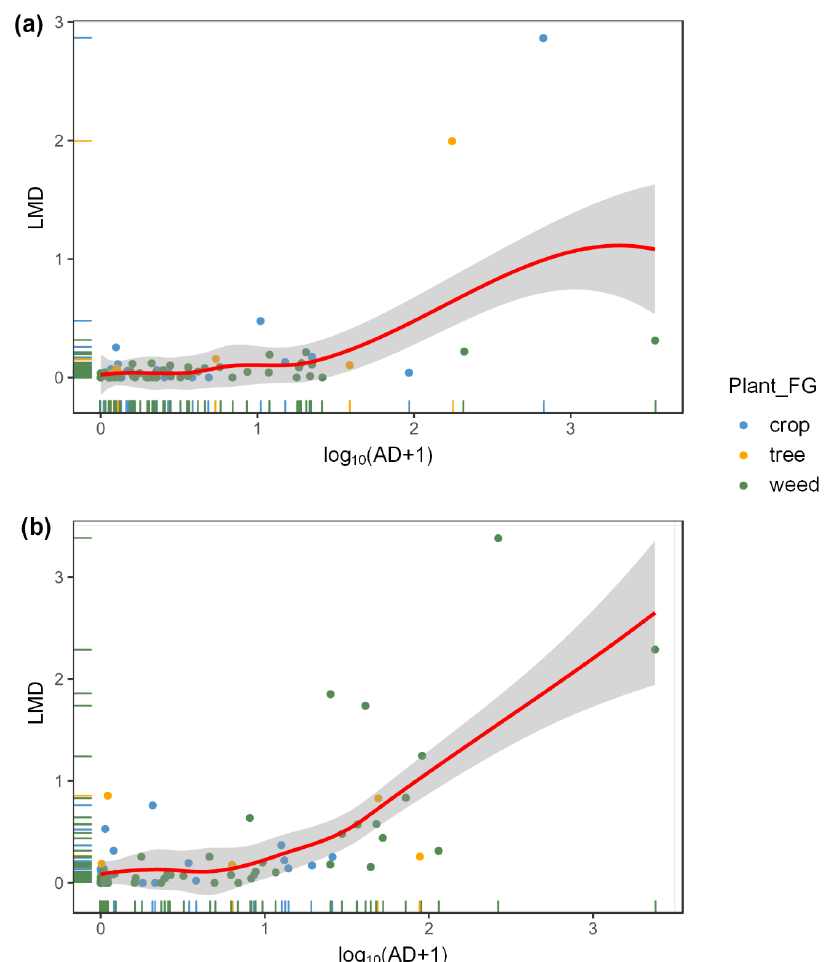
Figure 2. The relationship between aphid density (AD) and ladybeetle metapopulation density (LMD) atthe local field scale in 2013 and 2014. The statistical results of a negative binomial generalized linear mixed-effects model (GLMM model using the “glmer.nb” function in the “MASS” package of the R software) are shown in Table S2. Because theeffects of plant functional groups were not significant, we only provided the aphid effects here. The data points (with marginal rug) of different colors are for different plant functional groups, and the red smooth curve with 95% confidence interval band (shaded areas) is across all plant species in 2013 ( a ) and 2014 ( b ) due to no difference in population density in these functional plant taxa. Data on AD shown in the scatter plotswere transformed by log 10 (x + 1) before analysis.